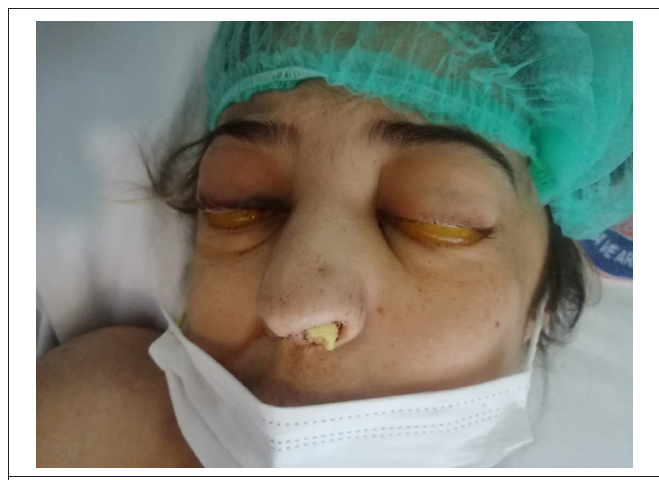
Figure 1. Eyelid edema and sudden loss of vision in the left eye.